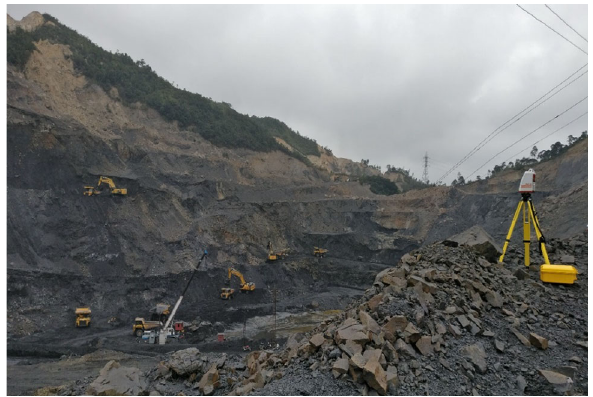
Fig. 2 A photo of the Coc Sau open-pit coal mine (the photo was taken by Michał M. Buczek on November 7, 2016)